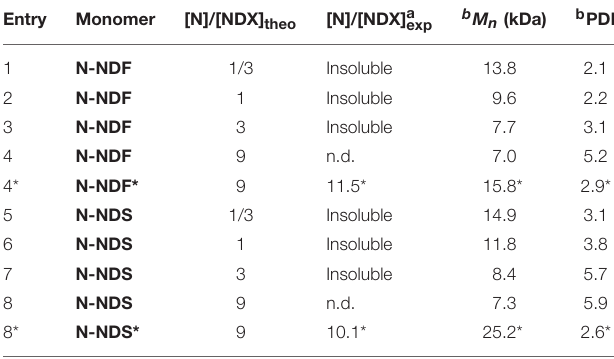
TABLE 3 | GPC characterization of crude copolymer via